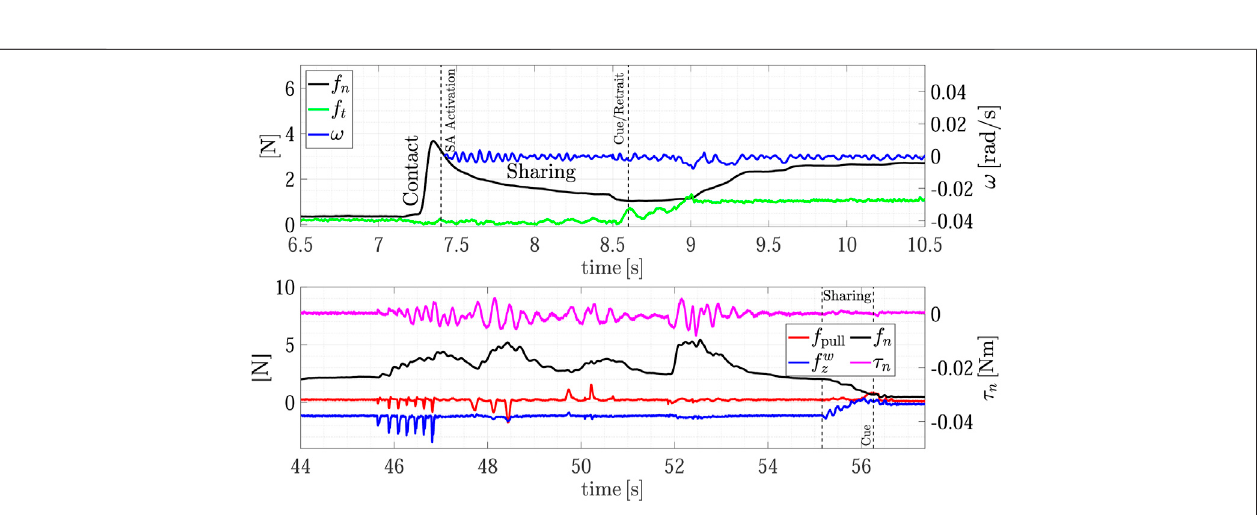
Frontiers in Robotics and AI |